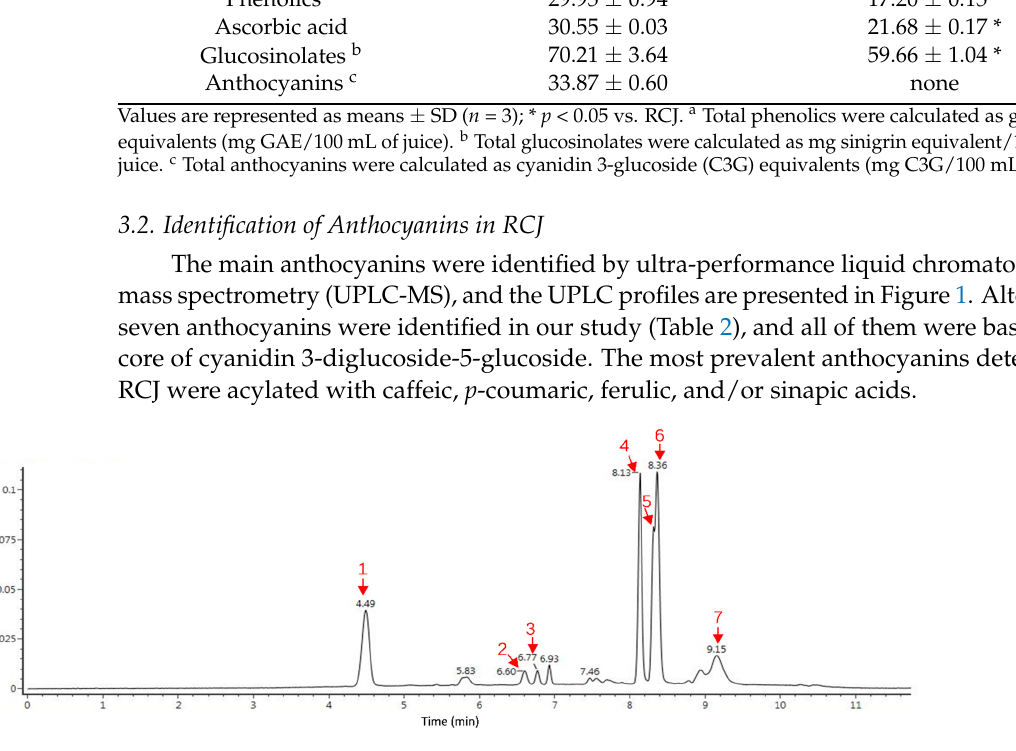
Figure 1. UPLC profile of anthocyanins in red cabbage juice. The corresponding compounds are list in Table 2. Table 2. Identification of red cabbage juice anthocyanins by UPLC-MS analysis. Retention Peak a [M] + ( m/z ) Fragments ( m/z ) Tentative Identification Time (min)